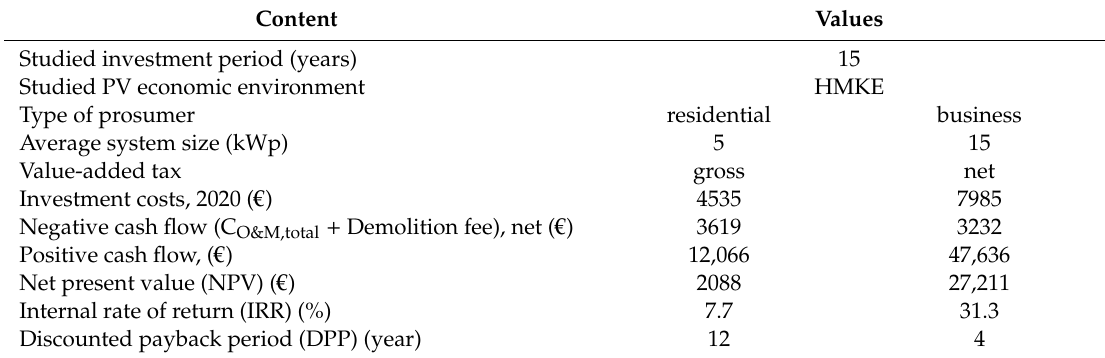
Table 9. The overall investment-e ffi ciency indices for the HMKE regulations in